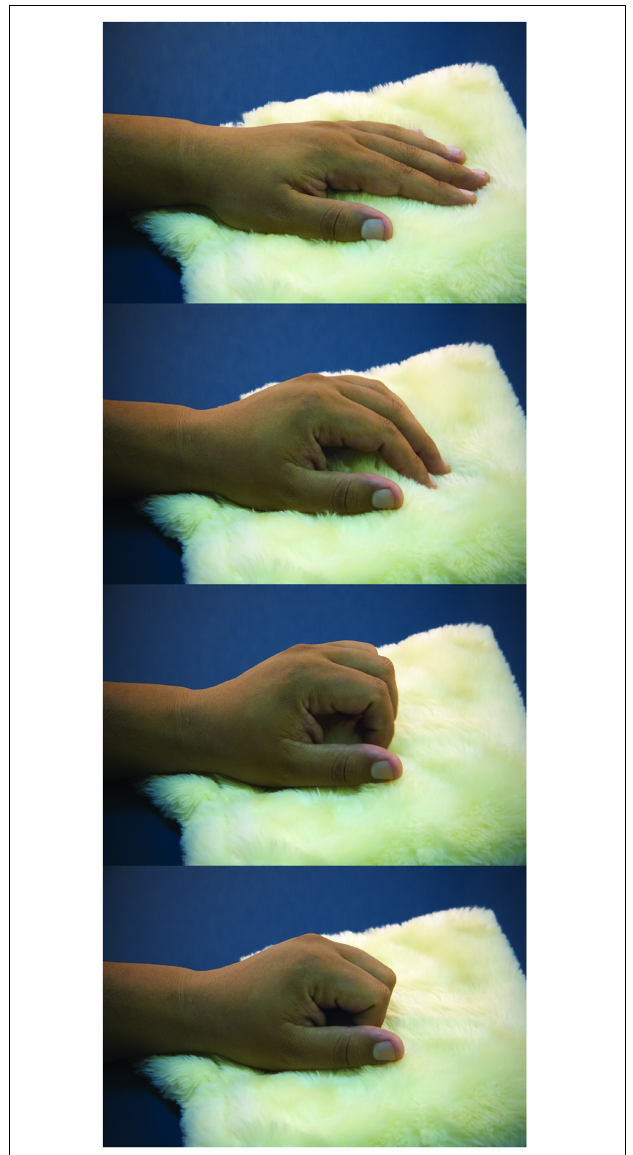
FIGURE 1 | Task. The sequential photographs illustrate the paced fingers flexion over the soft cloth, resembling a caress-like movement.